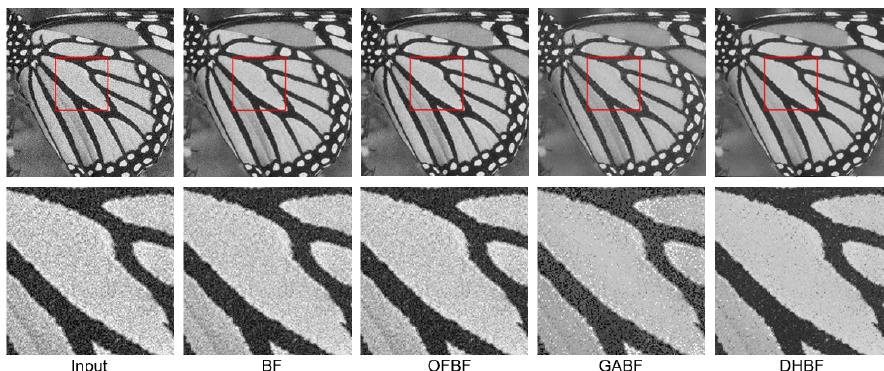
Figure 8. Visual comparison of the representative sample for image smoothing on Set5.